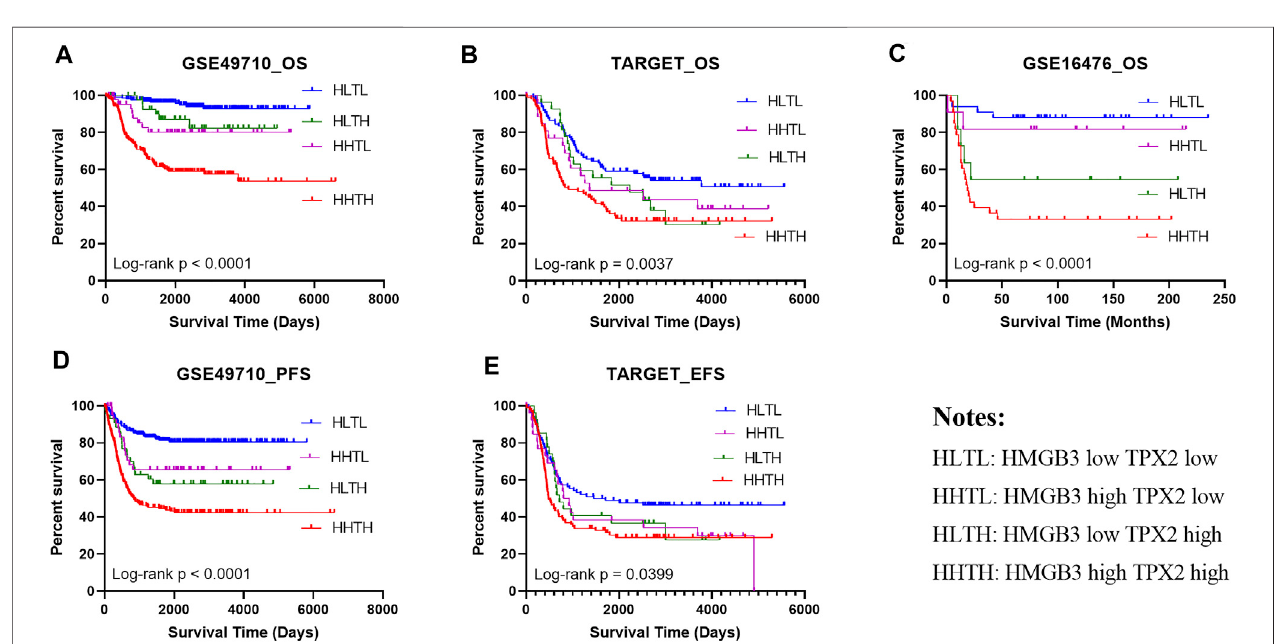
FIGURE 6 | High expression of HMGB3 and TPX2 correlated to inferior NB prognosis in multiple datasets. (A – C) , Overall survival (OS) of NB patients in three independent datasets. (D, E) Progression-free survival (PFS) and Event-free survival (EFS) in NB patients.